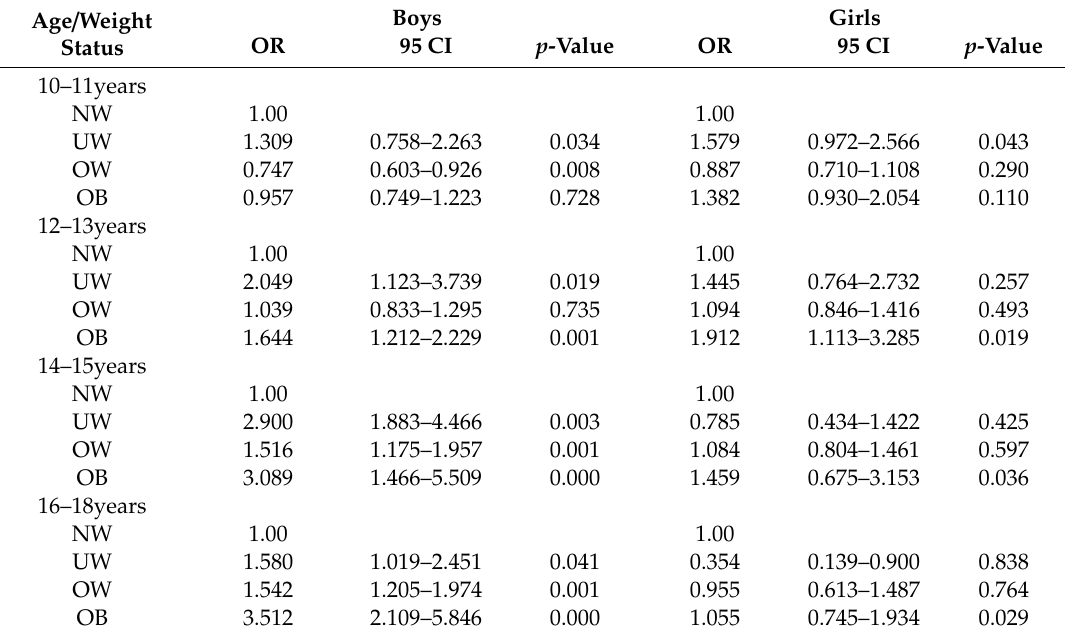
Table 3. Multi-level regression for physical fitness index and weight status by sex and